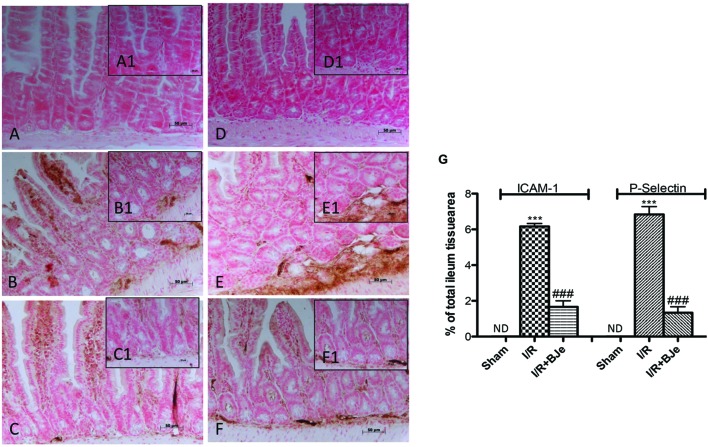
Effect of BJe on adhesion molecules expression. Ileum sections taken from I/R subjected- mice showed positive staining for ICAM-1 (B,B1,G) and for P-selectin (E,E1,G) compared to sham-operated mice (A,A1,D, D1,G). The degree of positive staining for adhesion molecules was reduced in tissue sections from mice treated with BJe (C,C1,F,F1,G). The figures are representative of at least three experiments performed on different experimental days. Data are indicated as means ± SEM of 10 mice for each group. ∗∗∗P < 0.001 vs. SHAM; ###P < 0.001 vs. I/R. ND, not detectable.